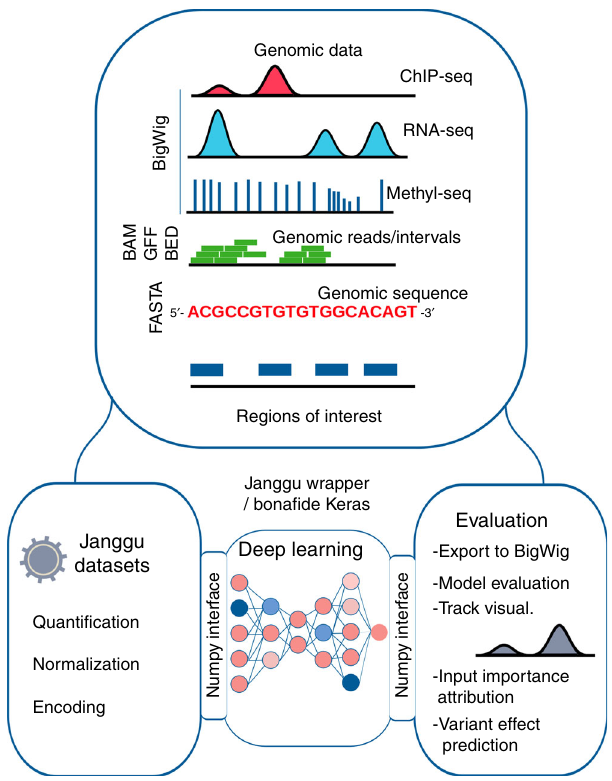
Fig. 1 Janggu schematic overview. Janggu helps with data aquisition and evaluation of deep learning models in genomics. Data can be loaded from various standard genomics fi le formats, including FASTA, BED, BAM, and bigWig. The output predictions can be converted back to coverage tracks and exported to bigWig fi